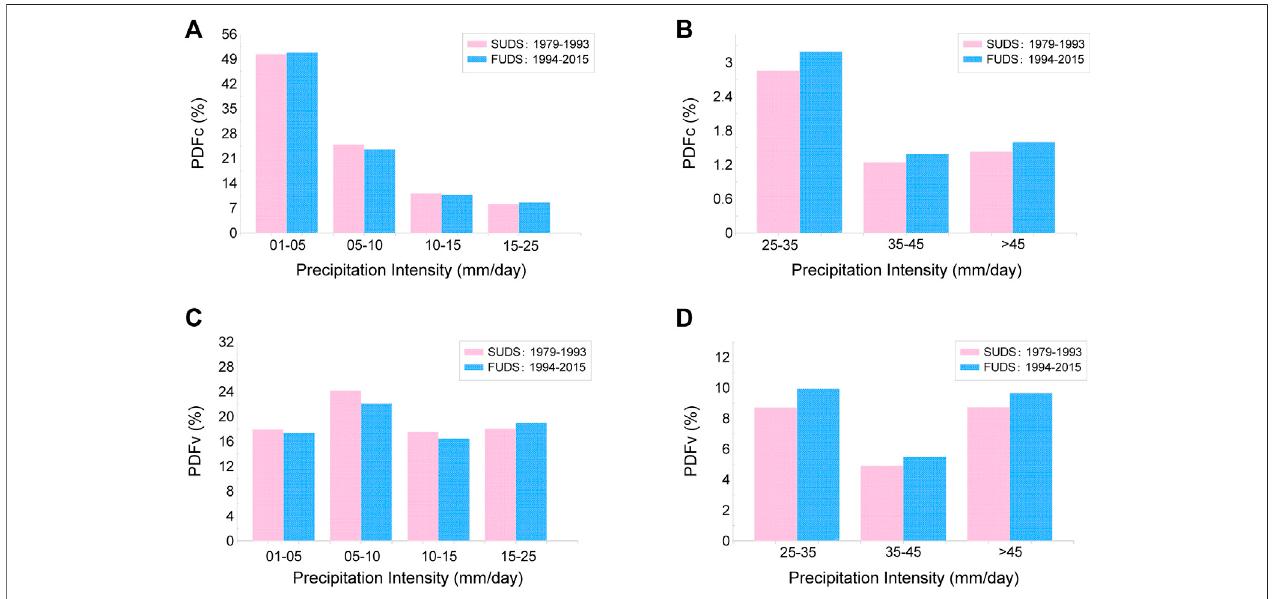
FIGURE 7 | Probability distribution functions (PDFs) by occurrence [PDFc; (A,B) ] and volume [PDFv; (C,D) ] for different intensities of summertime precipitation events during the slow urbanization development stage (SUDS) and fast urbanization development stage (FUDS) in the Sichuan – Chongqing area.